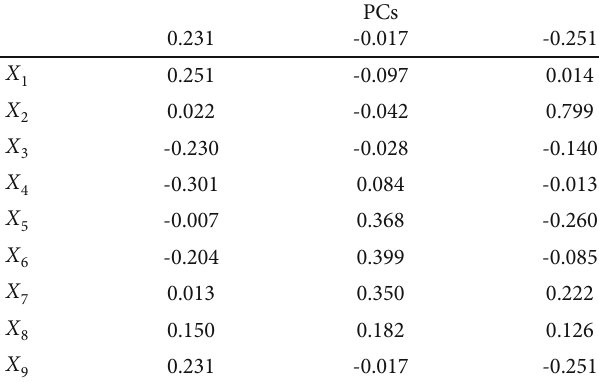
Table 4: Scoring coe ffi cients of